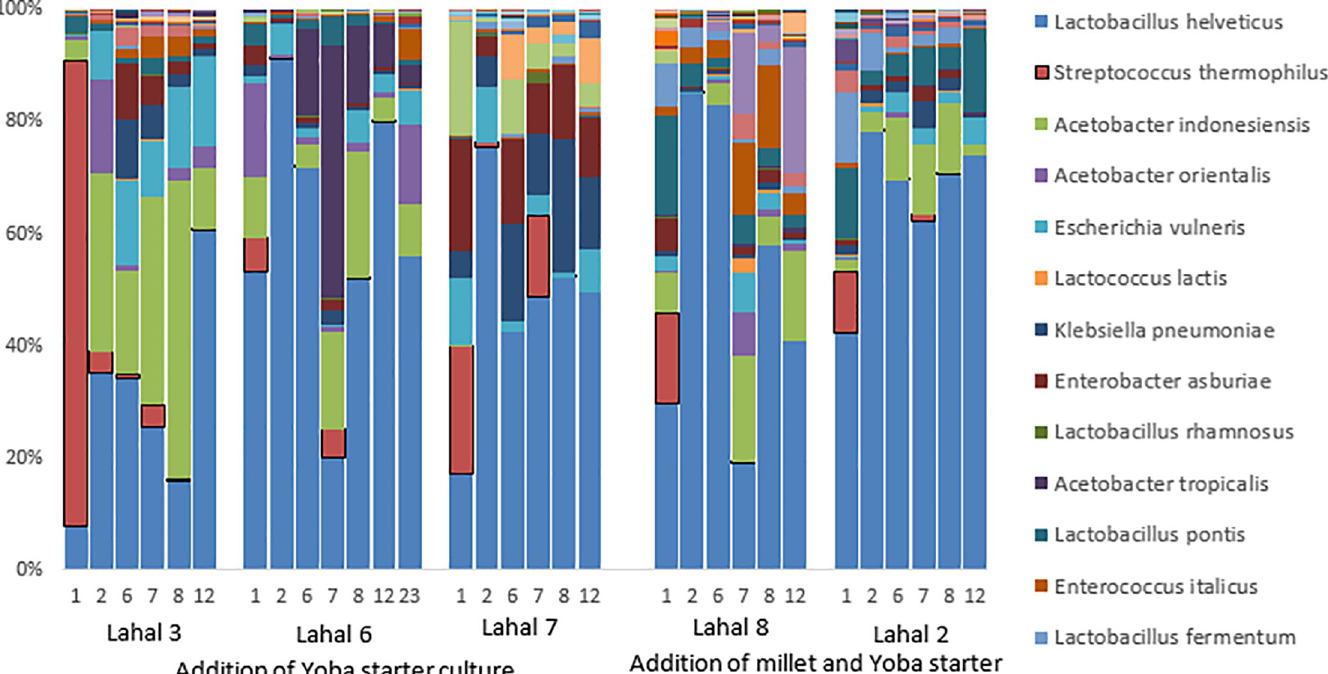
Fig 6. Community composition of the bacterial species in lait caille´ of lahal 2, 3, 6, 7, and 8 during the invasion experiment with Yoba starter culture. Numbers indicate fermentation rounds. Vertical axes indicates percentage of total reads within the sample. The thirteen species with highest abundance are indicated in the legend. The aim of the figure is to show the diversity found in the microbial communities of lait caille´ in terms of genus and species variation. For specific abundances of species and OTU, please refer to the sequencing data provided with this publication.